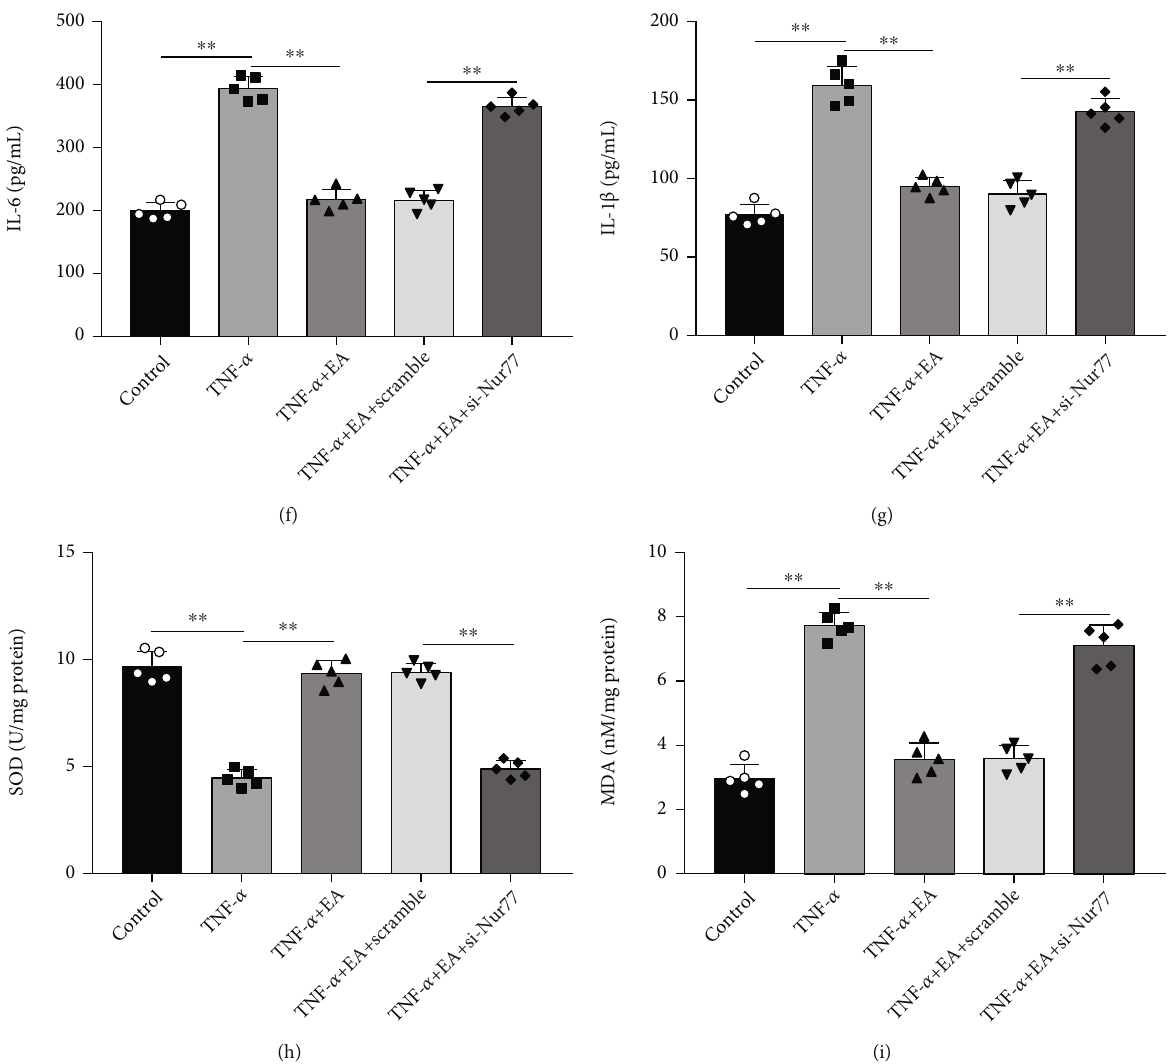
Figure 6: Nur77 knockdown reversed the e ff ects of EA on proliferation, in fl ammation, oxidative stress, and apoptosis in MH7A cells. TNF- α -treated MH7A cells were treated with 50 μ M EA alone or together with si-Nur77. (a) The mRNA expression of Nur77 was detected by RT- qPCR. (b) The protein expression of Nur77 was detected by Western blot analysis. (c) CCK-8 assay was performed to measure MH7A cell proliferation. (d, e) MH7A cell apoptosis was measured by fl ow cytometry. (f, g) The levels of IL-6 and IL-1 β in cell culture supernatant were detected by ELISA. (h, i) The levels of SOD and MDA in MH7A cells were examined by commercial kits. Data from at least three replicate experiments were presented as mean ± SD . N = 5 . ∗∗ P < 0 : 01